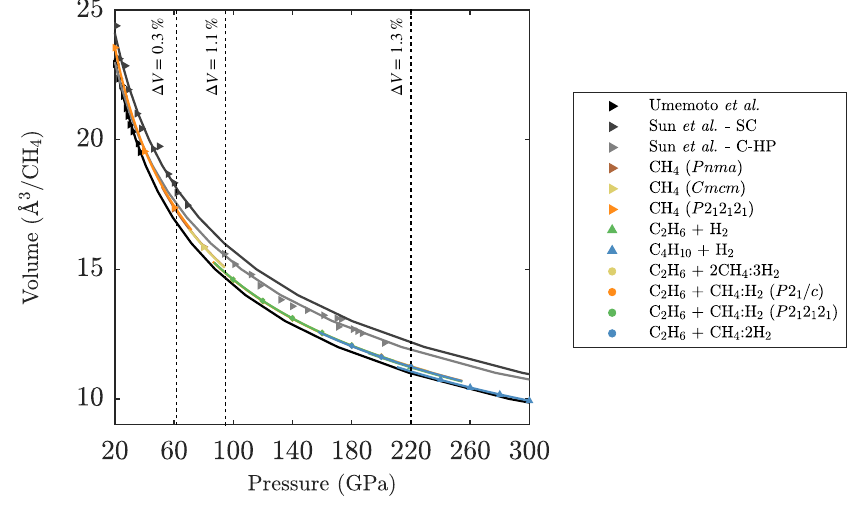
Figure 4. Pressure-volume equation of state for CH 4 . Gray-shaded symbols are experimental data points from Sun et al. [21] and Umemoto et al. [12]. Coloured data points are calculated in this work. Vertical lines indicate PBE transition pressures as per Figure 3. Solid lines are EOS fits to the respective data